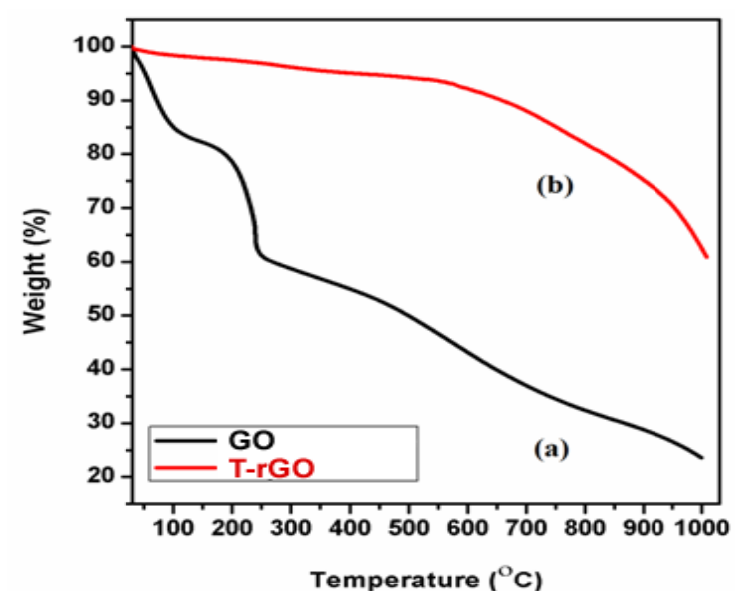
Figure 4. Thermogravimetric analysis of (a) GO and (b) T-rGO.